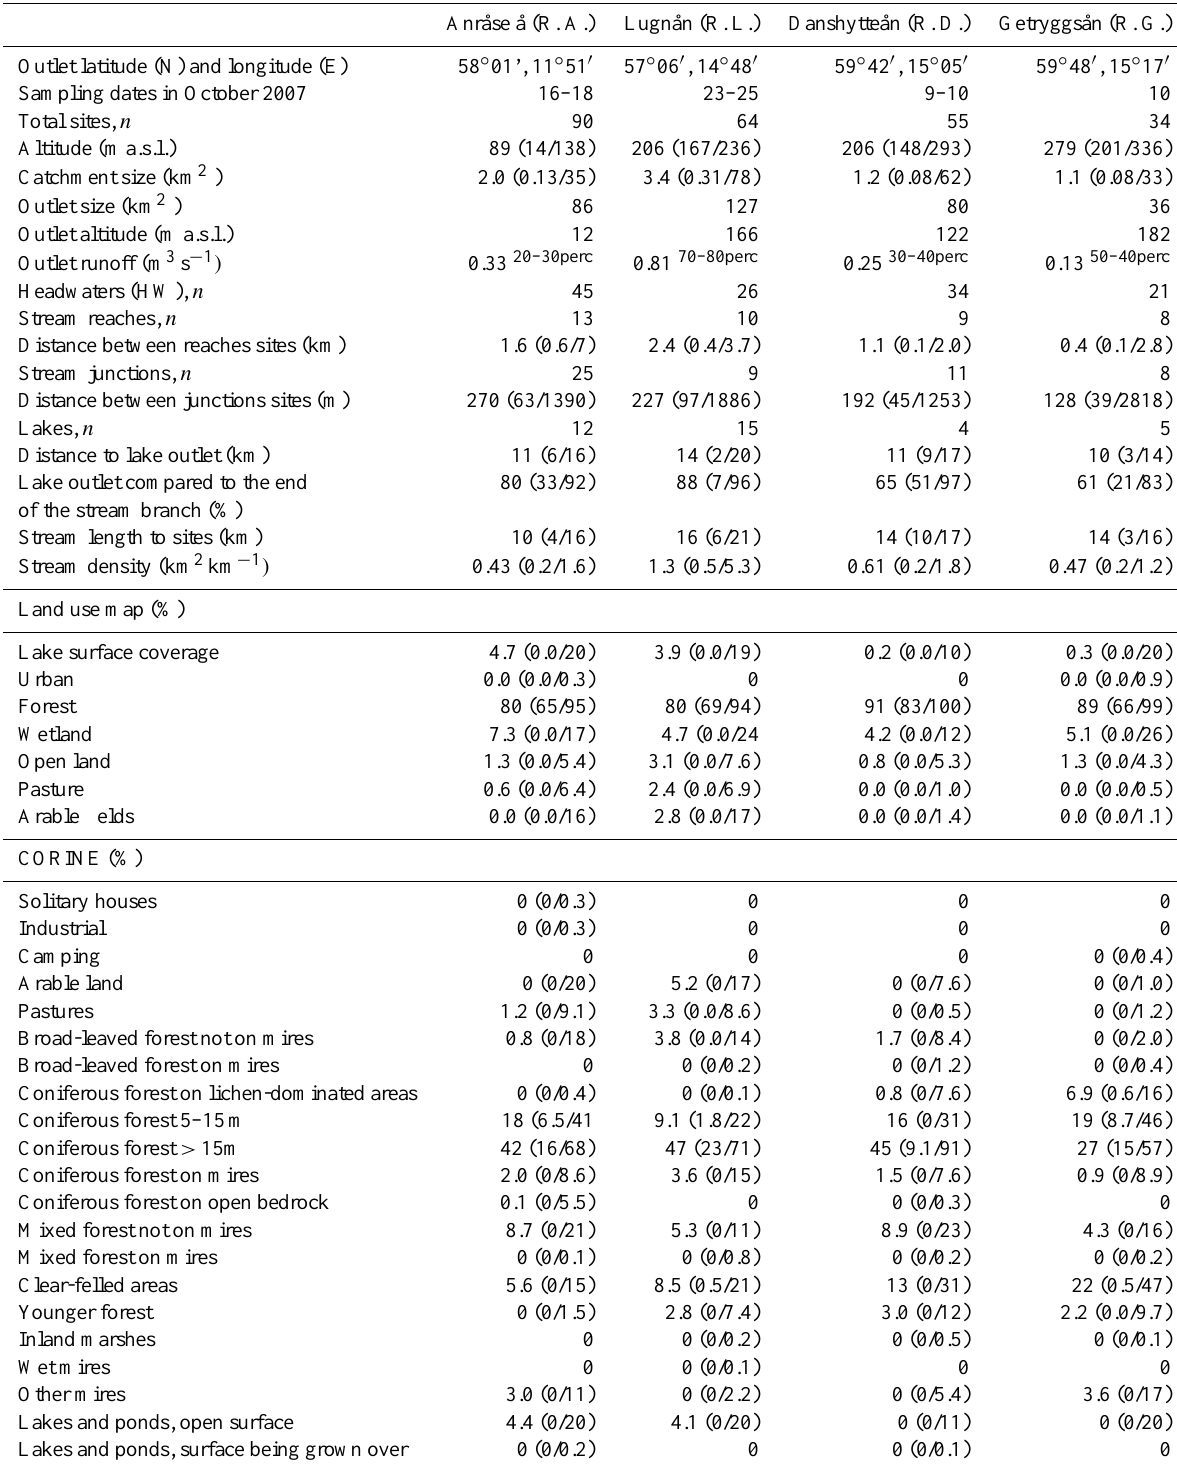
Table 1. Map material for each catchment, median with 5th and 95th percentiles in parentheses. Outlet runoff is the daily HYPE modelled runoff during sampling compared to percentiles (perc) for October 1990–2010. For more details, see the Methods